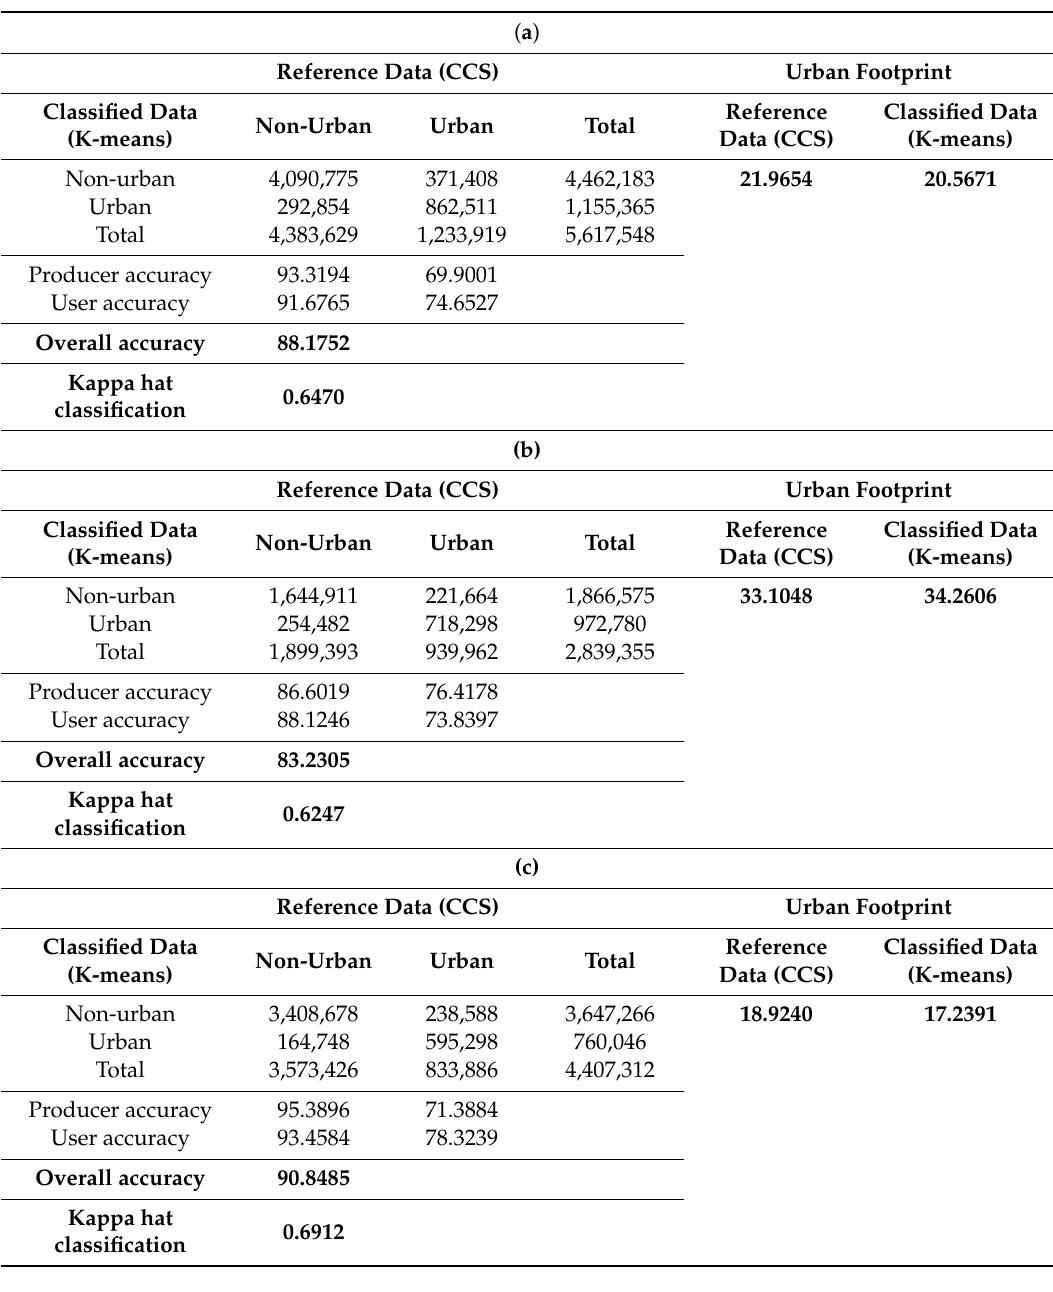
Table 9. Error matrix related to K-means classification performed on the target area of Venice ( a ), Padova ( b ) and Verona ( c ) (see Figure